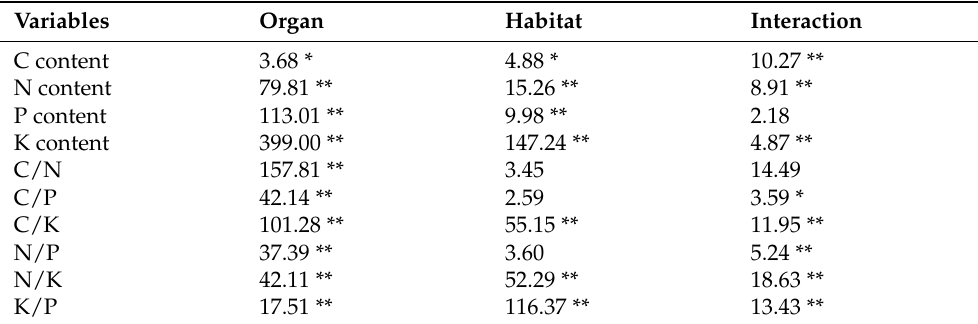
Table 1. GLM analysis of habitat and organ effects on C, N, P and K contents and their stoichiometric